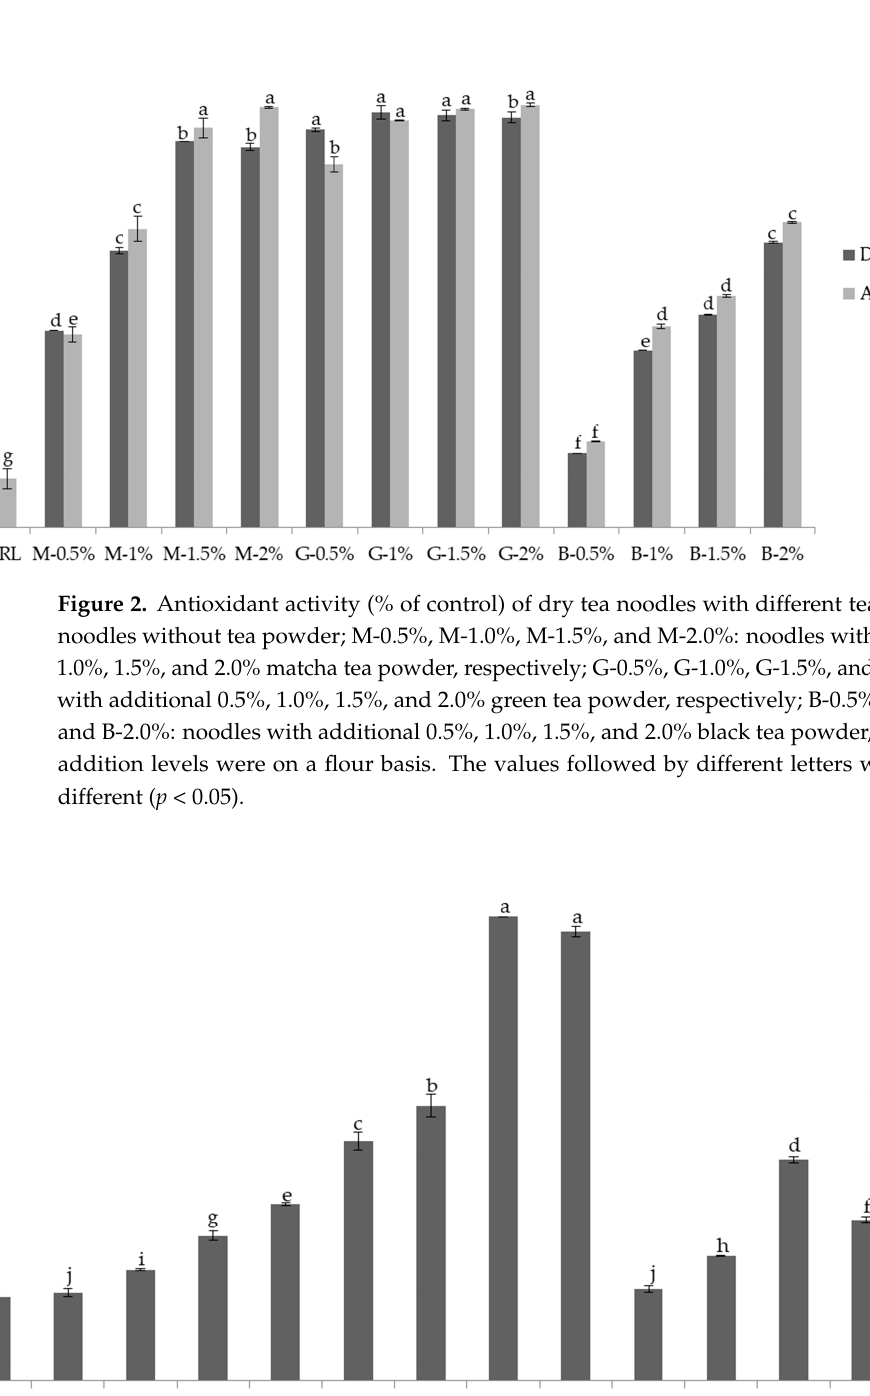
Figure 3. Total phenol content (TPC) of dry tea noodles with different tea extracts. CTRL: noodles without tea powder; M-0.5%, M-1.0%, M-1.5%, and M-2.0%: noodles with additional 0.5%, 1.0%, 1.5%, and 2.0% matcha tea powder, respectively; G-0.5%, G-1.0%, G-1.5%, and G-2.0%: noodles with additional 0.5%, 1.0%, 1.5%, and 2.0% green tea powder, respectively; B-0.5%, B-1.0%, B-1.5%, and B-2.0%: noodles with additional 0.5%, 1.0%, 1.5%, and 2.0% black tea powder, respectively; All addition levels were on a flour basis. The values followed by different letters were significantly different ( p < 0.05).